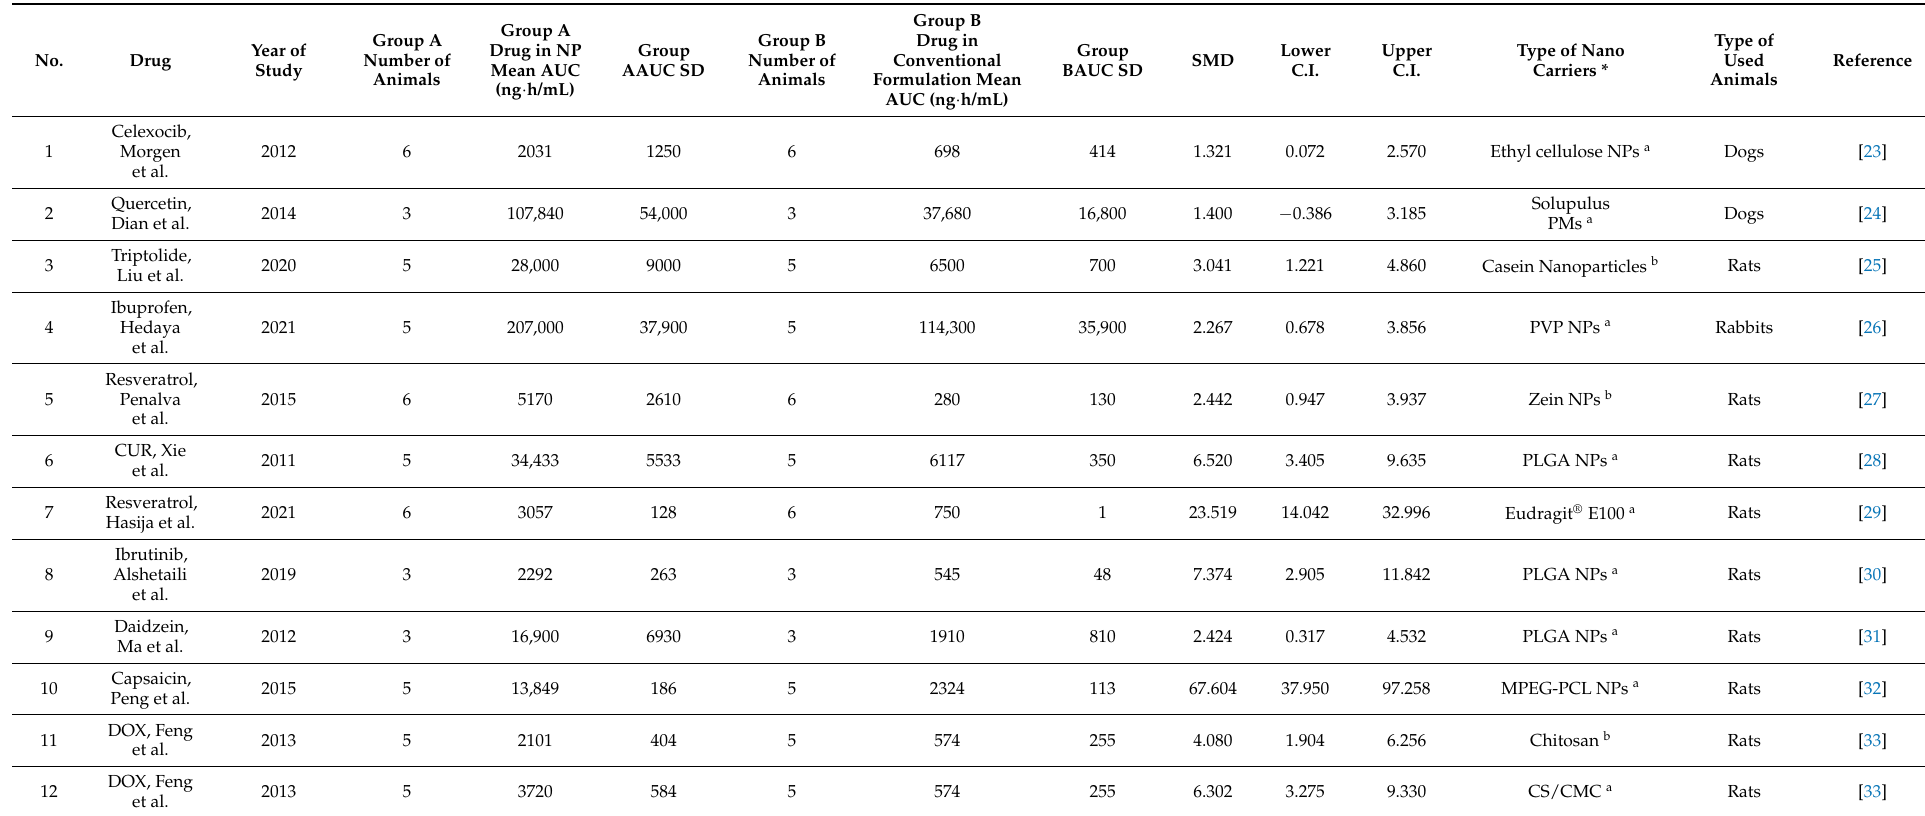
Table 1. Summary of the meta-analysis of the published studies investigating the bioavailability of different orally loaded drugs in polymeric nano-particulate systems, compared to conventional delivery systems as